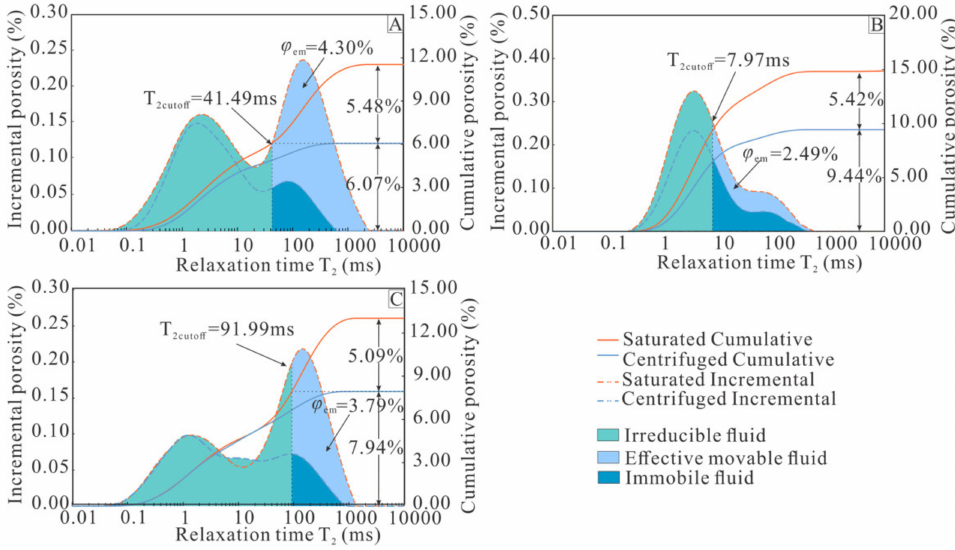
Figure 9. NMR T 2 spectra and effective movable fluid distribution obtained from sandstone samples in the E s4 reservoirs. ( A ) Sample C141-1, ϕ = 17.5%, K = 11.61 mD; ( B ) Sample C406-1, ϕ = 13.6%,